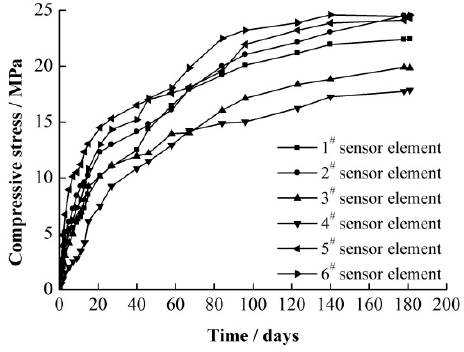
Table 5. Principal stress results for the test points in the PDS No. 1 coal mine.